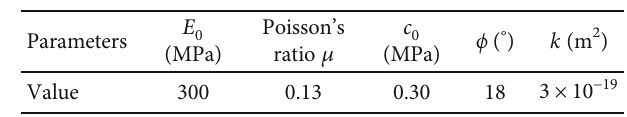
Table 2: The known parameters for clayey rock.